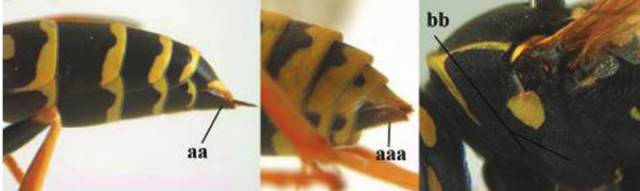
– Apical half of sternite VI largely black, if with reddish or yellowish apical part then pale part smaller than black part of tergite VI (aa), but especially in P. as- socius sometimes paler and not obviously smaller than black part of last tergite (aaa); mesopleuron ventrally evenly and finer sculptured (bb) ................... 15